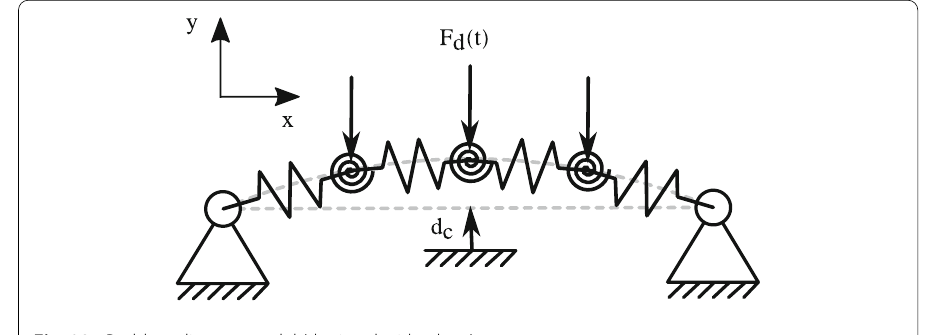
Fig. 23 Problem discrete model (depicted with 4 bars)